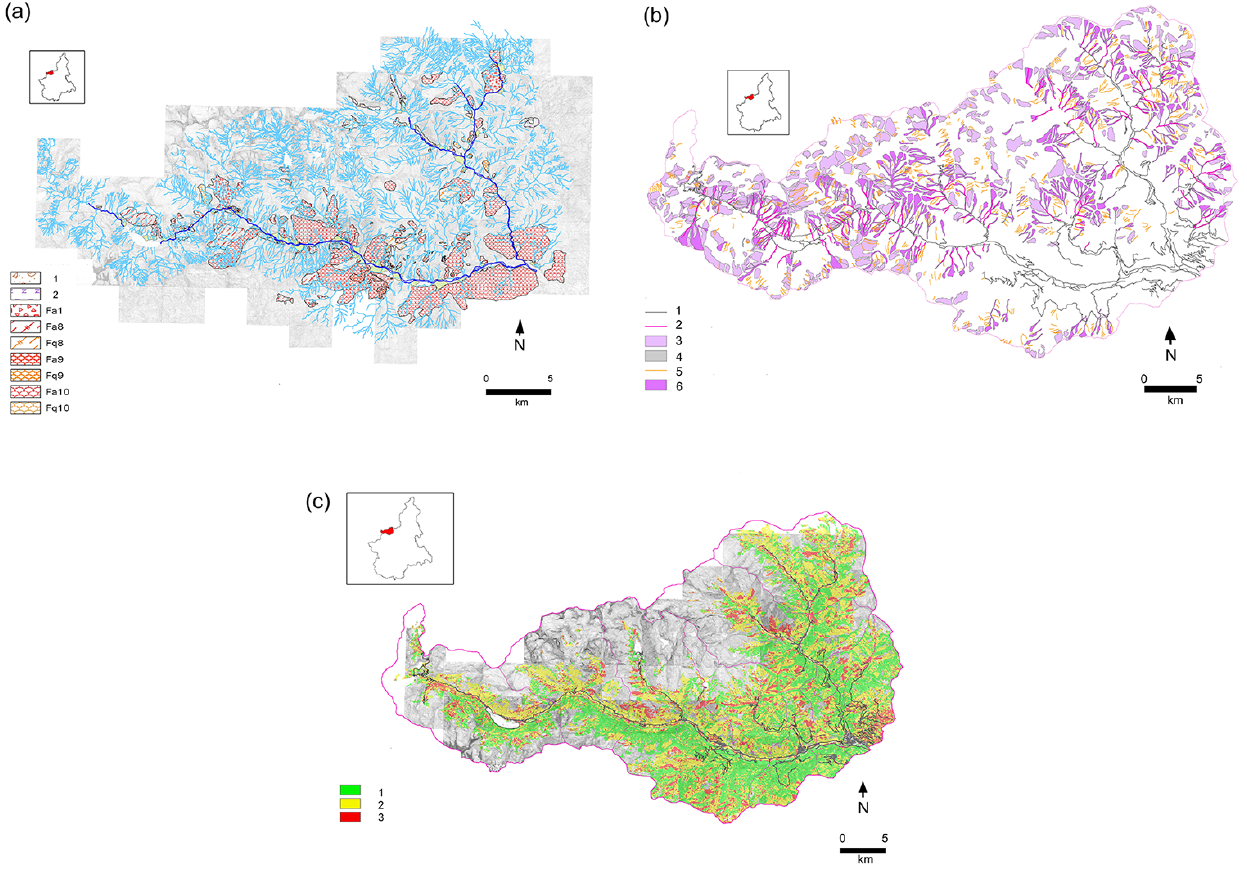
Figure 4. Demonstrative synoptic maps, obtained by a combination of 90 layers at original 1:5000 scale, draft for the CPP of the Orco and Soana valleys. (a) Geomorphological setup. 1: detritus deposits, 2: glacial deposits, Fa1:active rockfall, Fa8: active GSD, Fq8: quiescent GSD, Fa9: recent soil slip, Fq9: historical soil slip, Fa10: active, complex landslide, Fq10: quiescent, composite landslide. (b) Multi-temporal occurrence of snow avalanches. 1: road network, 2: snow avalanche track, 3: slope areas exposed to avalanches, 4: areas provided with protective works, 5: minor avalanches, 6: avalanche-prone impluvia and minor catchments. (c) Wildfire-related risk classes, drawn by a purposely developed algorithm (see Sect. 3), for low, medium and high risk (1, 2, 3,